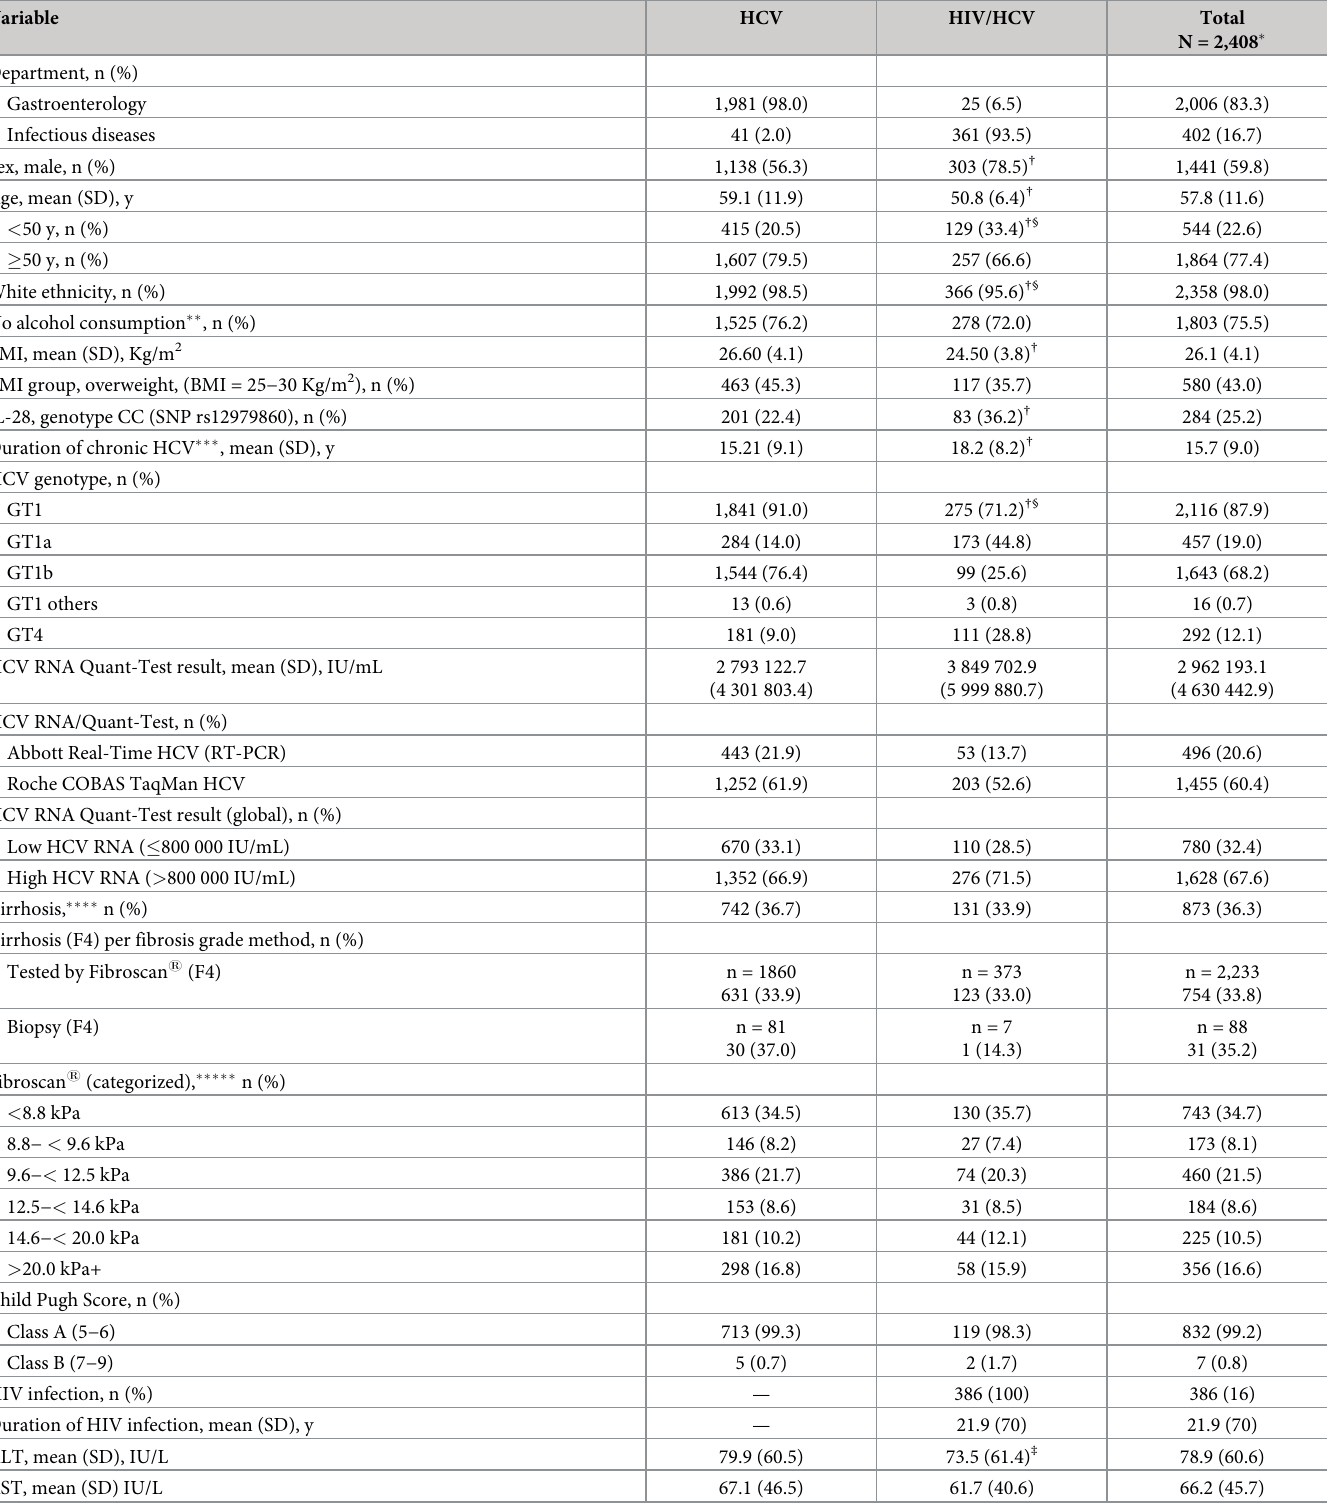
Table 1. Demographic and clinical characteristics of patients with Chronic HCV and HIV/HCV treated With OBV/PTV/r ± DSV ±